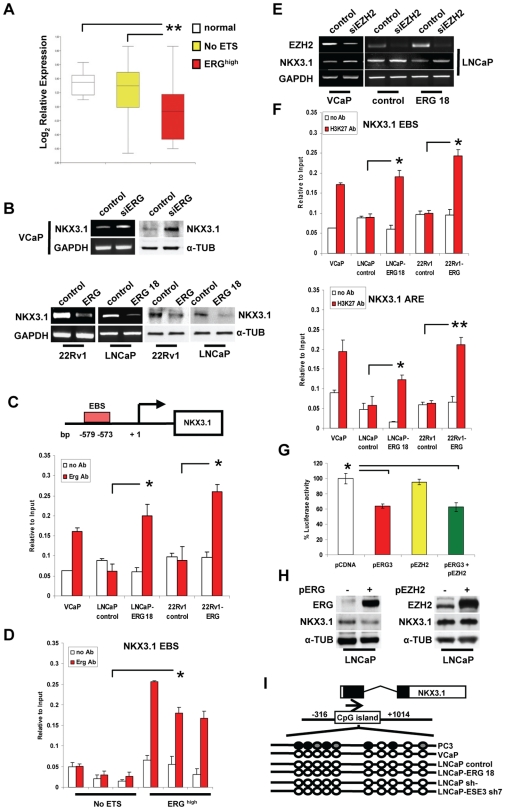
ERG represses Nkx3.1 expression.
A. Nkx3.1 expression in normal and tumor tissue samples. B. Nkx3.1 level in LNCaP cells transiently transfected with empty (ev) or ERG expression (Erg) vector determined by Western blot (upper panel), Nkx3.1 level in VCaP cells transiently transfected with siERG and control siRNA determined by RT-PCR and Western blot (middle panel), Nkx3.1 level in control and stable ERG-expressing 22Rv1 and LNCaP cells analyzed by RT-PCR and Western blot (bottom panel). C. Binding of ERG to the Nkx3.1 promoter determined by ChIP and qPCR in indicated cell lines. Negative controls are shown in Fig. S7A. D. Tissue specimens of ERGhigh and NoETS tumor were subjected to ChIP with anti-ERG antibody and analyzed by qPCR. Negative controls are shown in Fig. S7B. E. VCaP, parental (control) and ERG expressing (ERG 18) LNCaP cells transfected with EZH2 specific (siEZH2) and control siRNA and analyzed by RT-PCR. F. ChIP with an antibody for methylated H3K27 and qPCR with primer sets encompassing the EBS (upper panel) and an androgen responsive enhancer (ARE) (bottom panel) in the Nkx3.1 gene. ETS2 was used as negative control (Fig. S8A). G. Nkx3.1 promoter activity in LNCaP cells transfected with human Nkx3.1 promoter reporter along with the indicated expression vectors. Luciferase reporter activity was measured after 24 h. H. Nkx3.1 protein level in LNCaP cells transiently transfected with empty (−) or either ERG (pERG) or EZH2 (pEZH2) expression vector determined by Western blot. I. Nkx3.1 promoter methylation was assessed by bisulfite-treated DNA sequencing. Empty and filled circles represent unmethylated and methylated CpG sites, respectively. *, p<0.01; **, p<0.001.